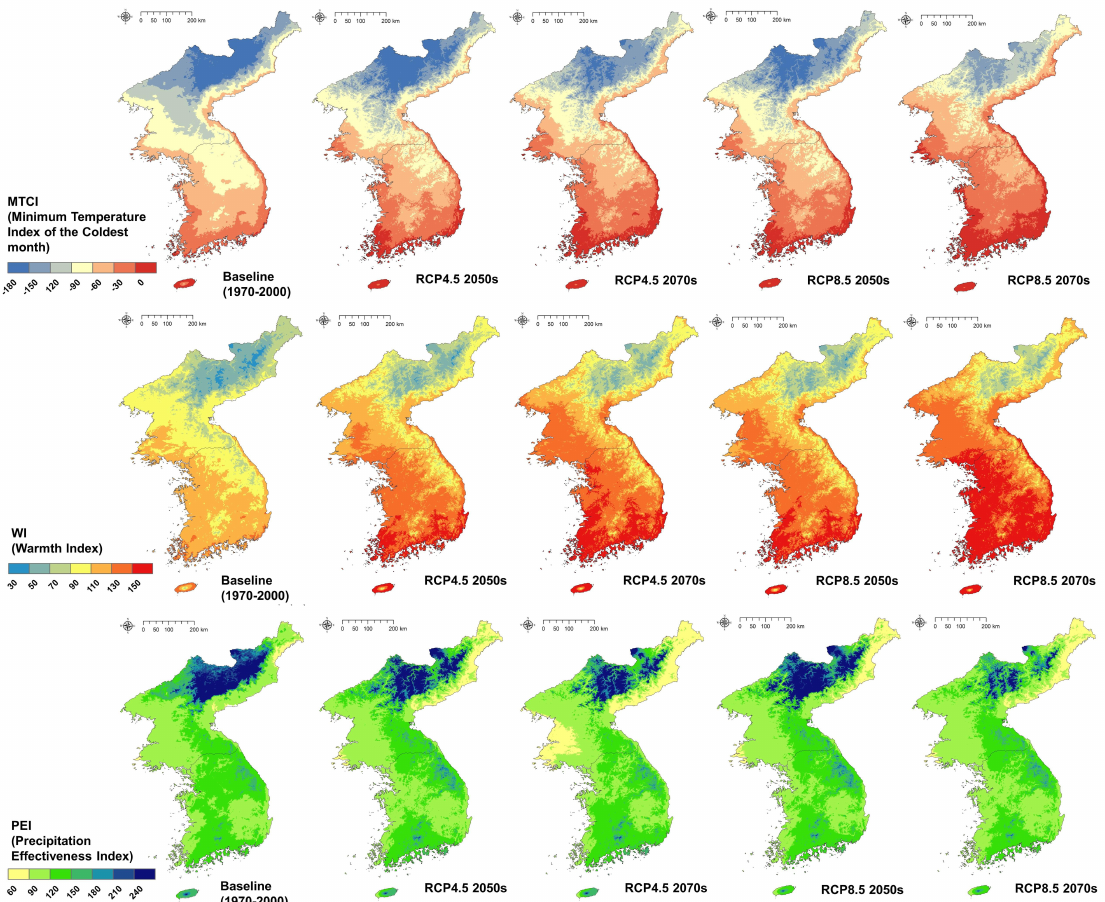
Figure 2. Three climate indices calculated for baseline and future